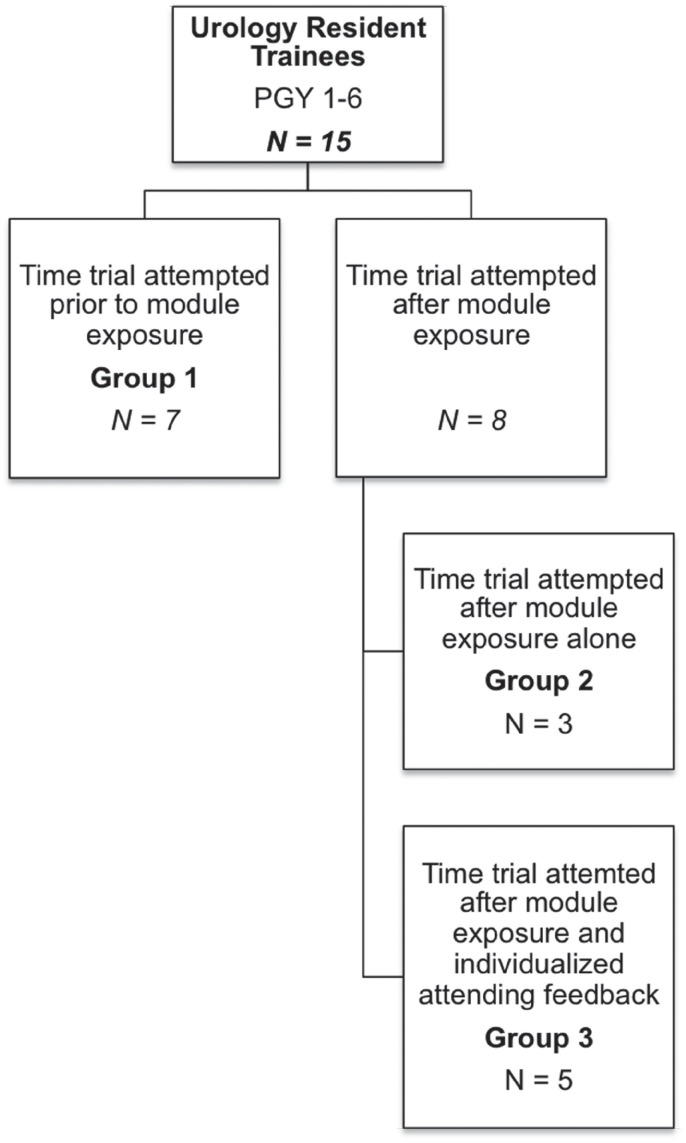
Description of UCSF urologic trainee cohort teaching exposures in each intervention arm.